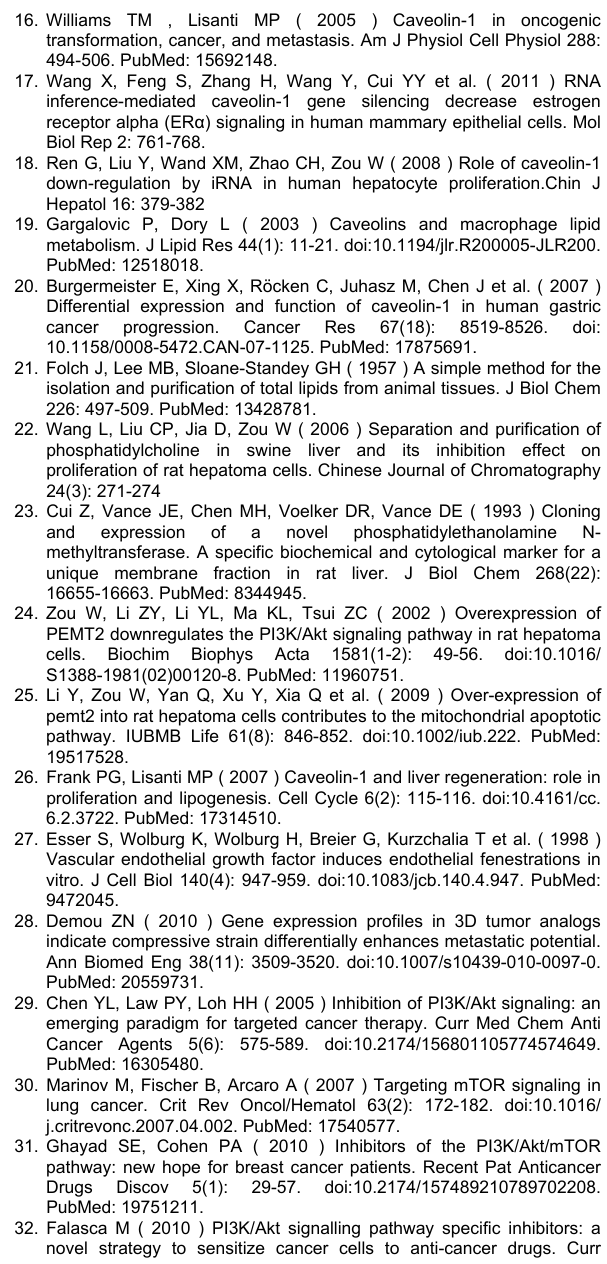
Figure S1. Inhibition rate with treatment of ChoPlas by MTT test (24h and 48h). CBRH-7919, HepG2, SMMC7721, HL7702 and Chang’s liver cells (1×104 cells/well) were seeded in a 96-well plate with a medium supplemented with 10% FBS and incubated for 24 h, respectively. Cells were then treated with 25μmol/L of ChoPlas in 20mmol/L ethanol for 24h and 48h. And then viable cells were stained with MTT and resulting formazan crystals were dissolved with DMSO. The absorbance